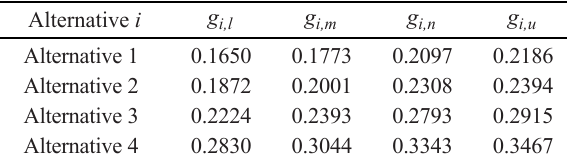
Table 5. Ranking of alternatives according to